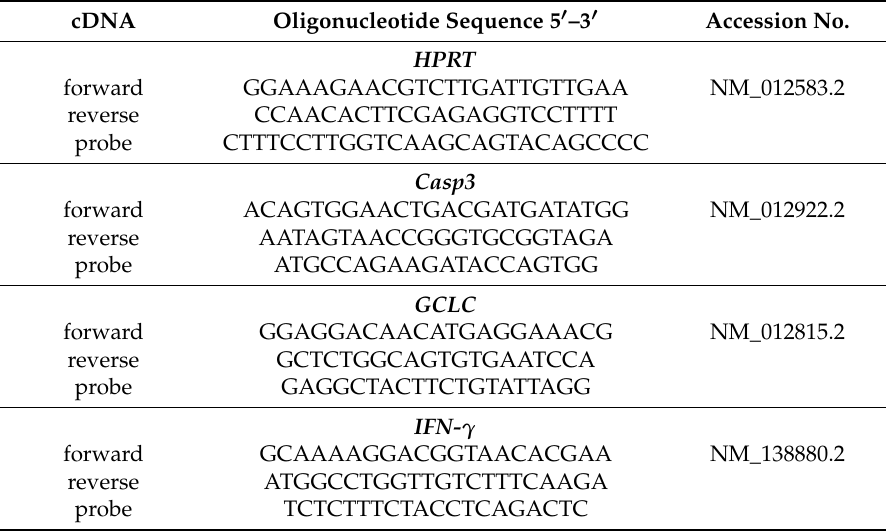
Table 1. Sequences of oligonucleotides. cDNA Oligonucleotide Sequence 5 (cid:48) –3